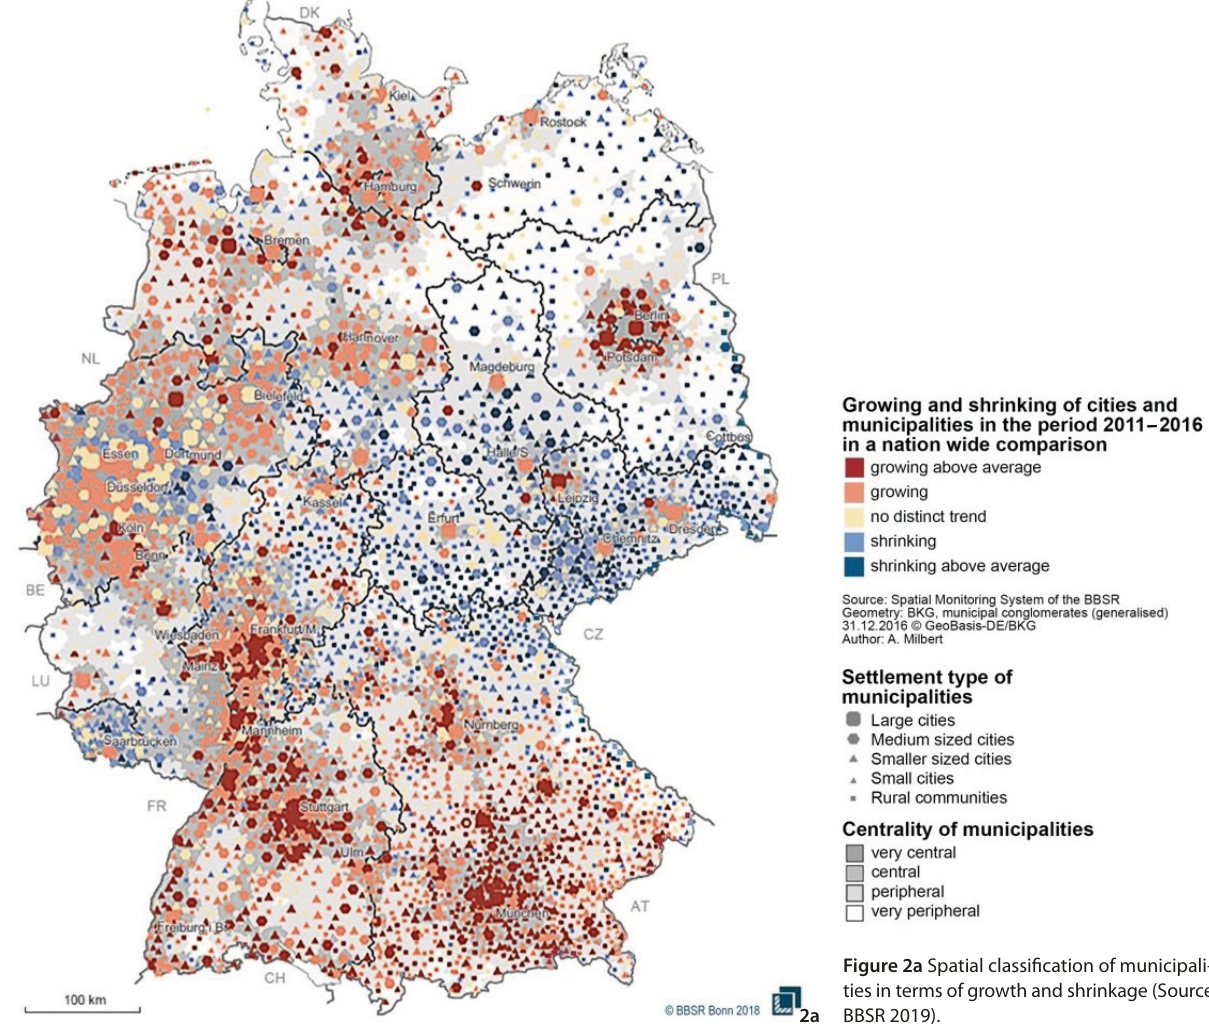
Figure 2a Spatial classification of municipali- ties in terms of growth and shrinkage (Source: BBSR